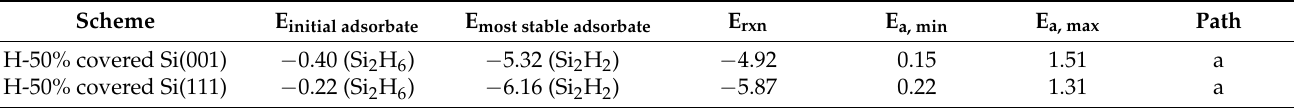
Table 1. Comparison of E initial adsorbate , E most stable adsorbate , E rxn and E a, min and E a, max (eV) on the H-50% covered Si(001) and Si(111)